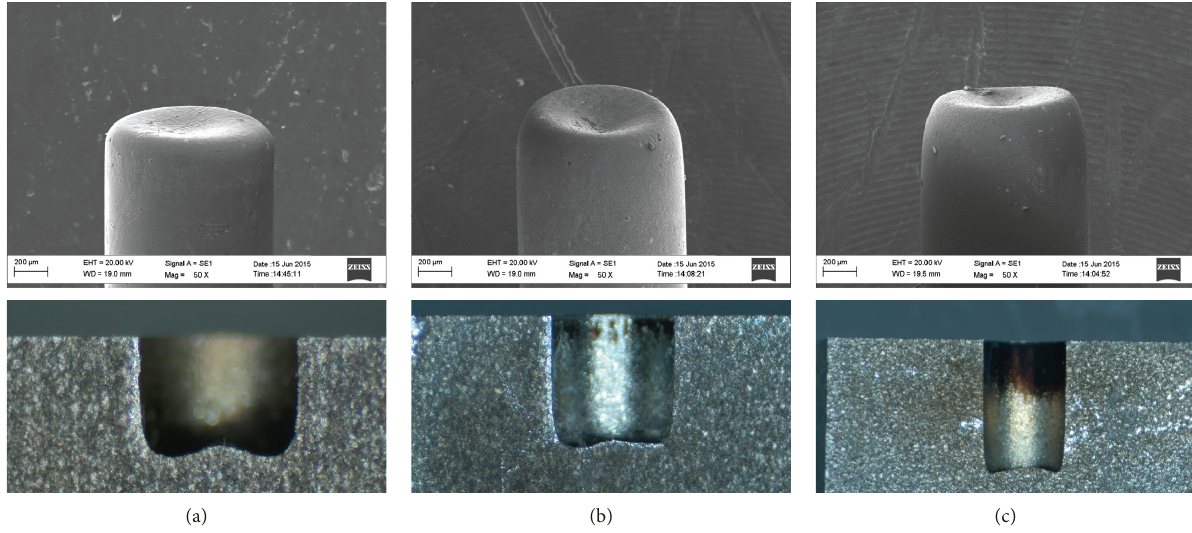
Figure 2: Electrode shape changes with different machining times (no. 2 of Table 1). (a) 15min. (b) 30min. (c) 60min.